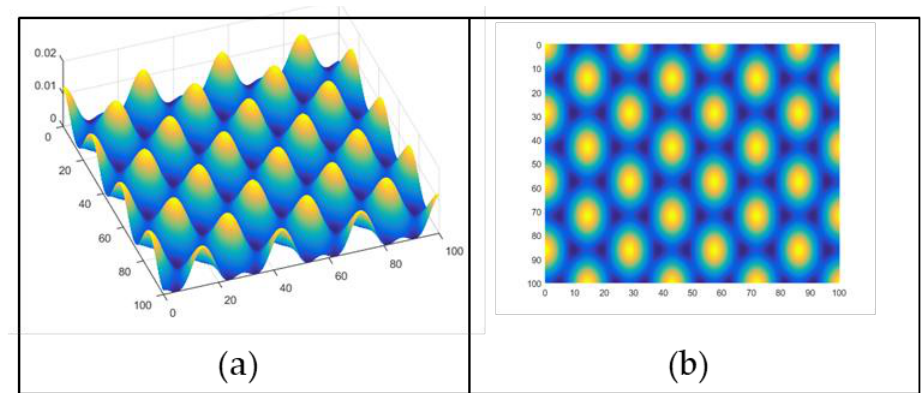
Figure 3. Pattern of light intensity produced by the interference of three beams: ( a ) 3 D view; ( b ) top view calculated with an angle between beams of 81 degrees.